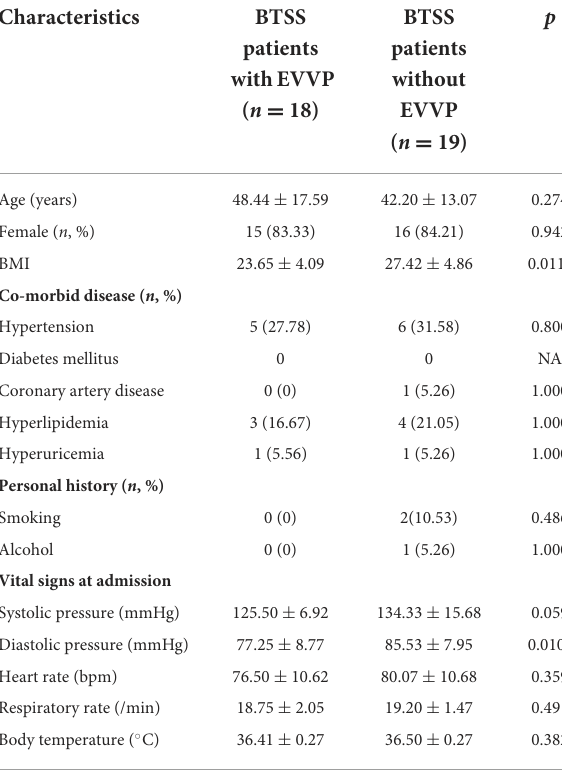
TABLE 1 Demographic features of the BTSS patients. TABLE 2 The demographic characteristics of the BTSS patients with or without EVVP.